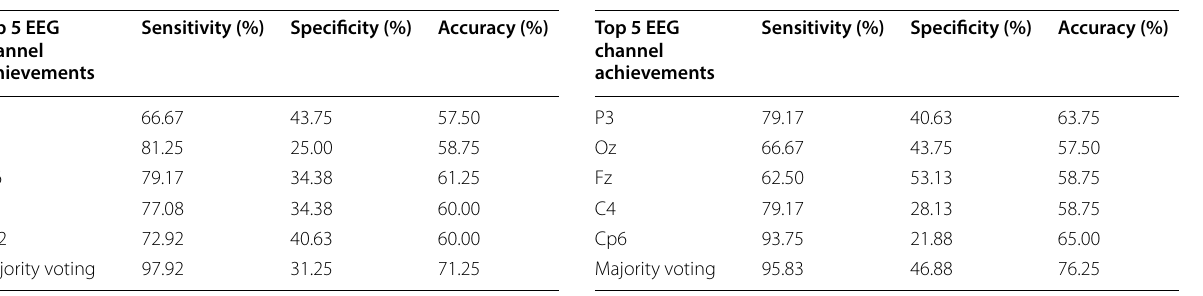
Table 10 Top 5 EEG channel achievements on